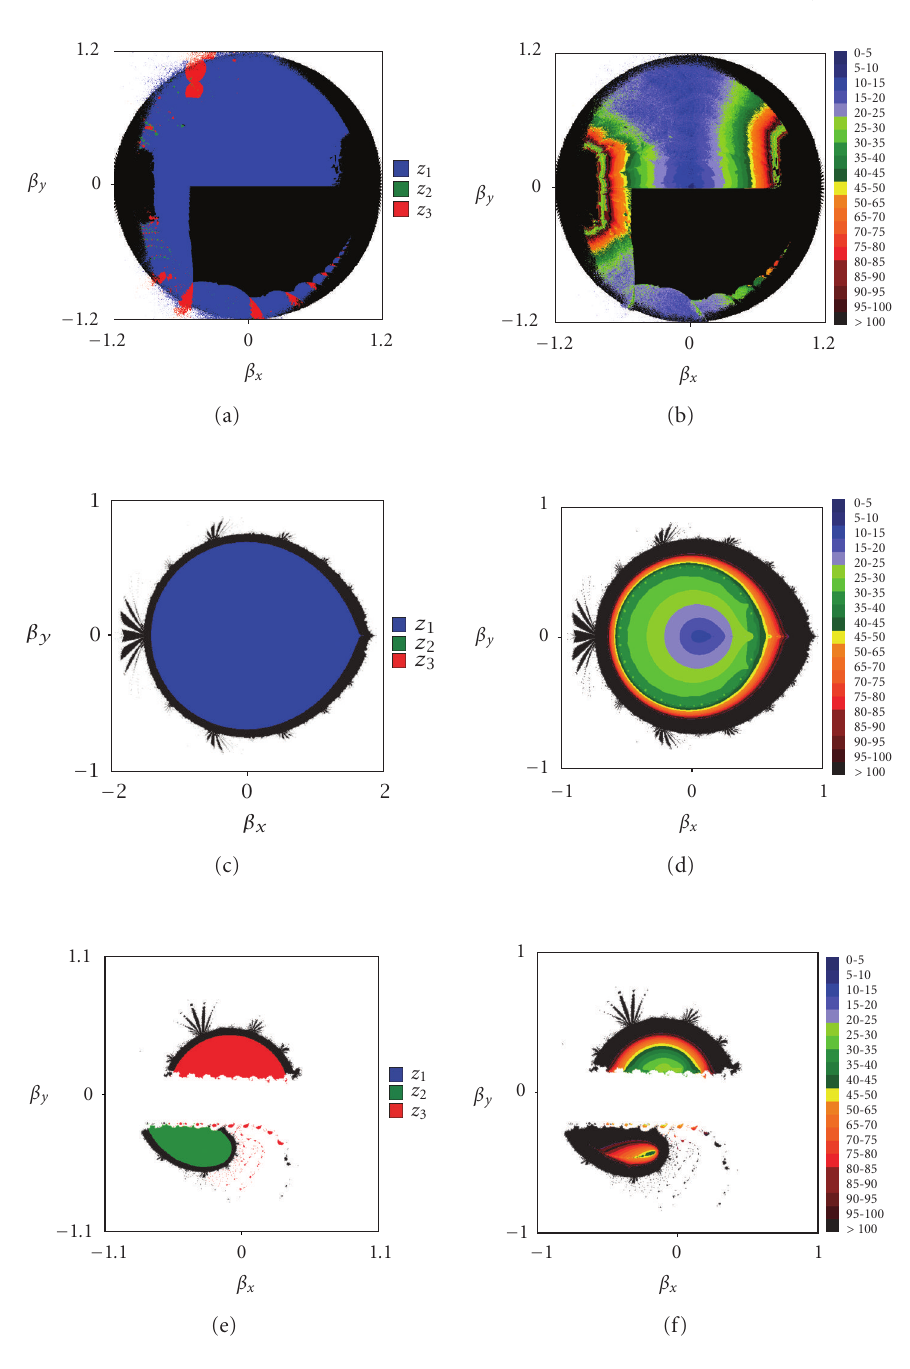
Figure 4.9. Disks of convergence: (a)–(b) (cid:3) (1 . 2 − i , β ) with W-L.S., (c)–(d) (cid:3) (0 . 0, β ) with λ = 0 . 2, (e)–(f) (cid:3) (0 . 5+ i , β ) with λ = − 0 . 2 − i · 0 .